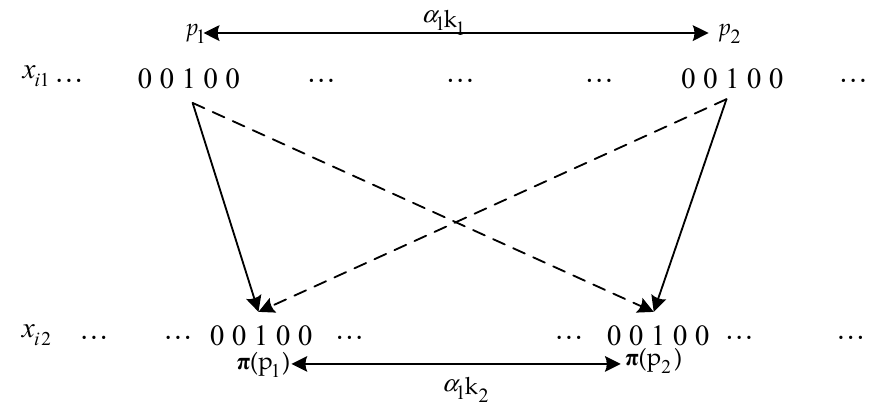
Figure 2. Weight-2 information sequence is mapped to weight-2 information sequence with similar pattern after permuted through interleaver.